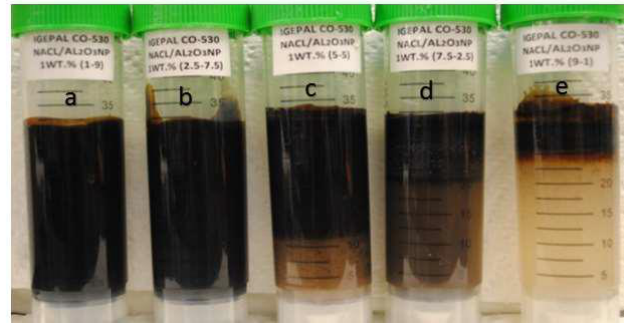
Figure 5—IGEPAL CO-530 with SiO